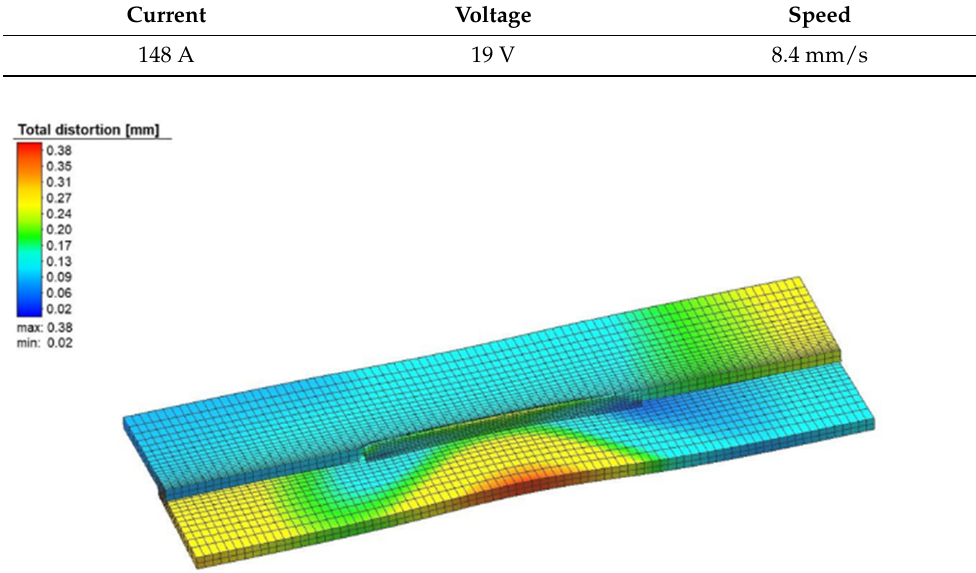
Figure 10. Maximum distortion using optimum weld parameters.